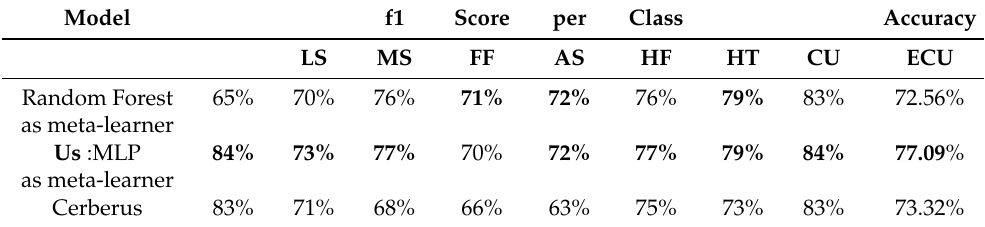
Table 16. Comparison with Variation of the Stacking Learning Technique.